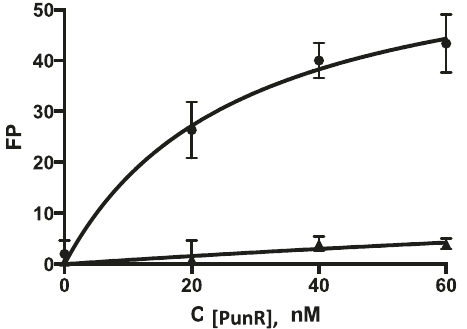
Fig. 3 DNA binding assays with PunR. Binding of puri fi ed PunR protein to the predicted DNA sequence upstream of punC was assessed by the fl uorescent polarization assay in the presence of 0.35 mM